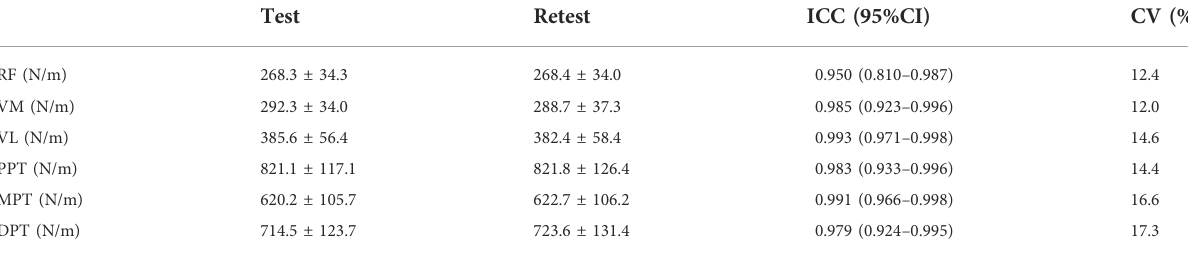
TABLE 1 Reliability assessment of stiffness measurements (Mean ± SD).